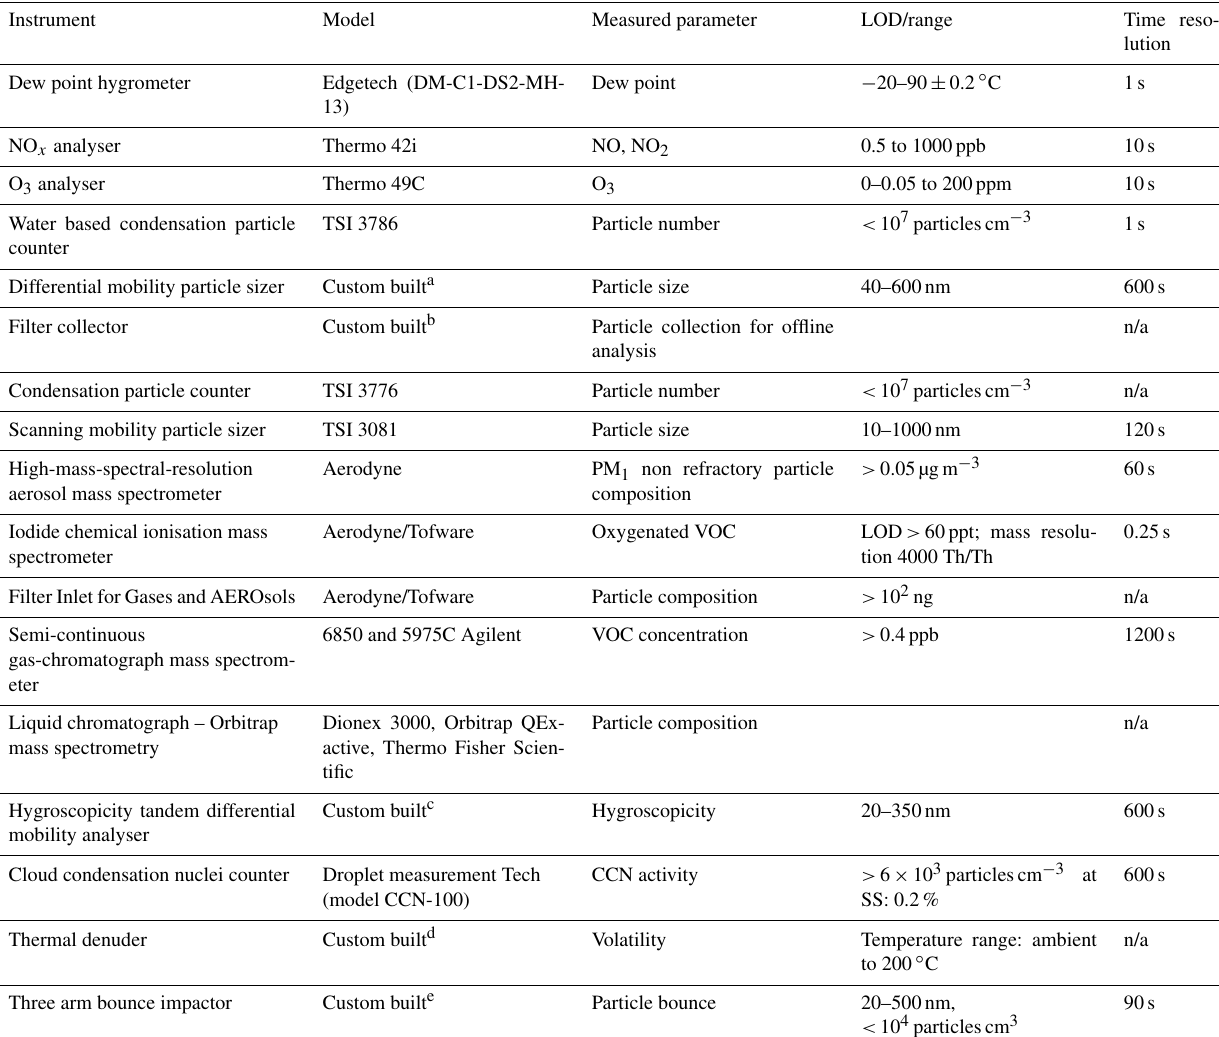
Table 2. List of instrumentation employed over the course of the study. n/a: not